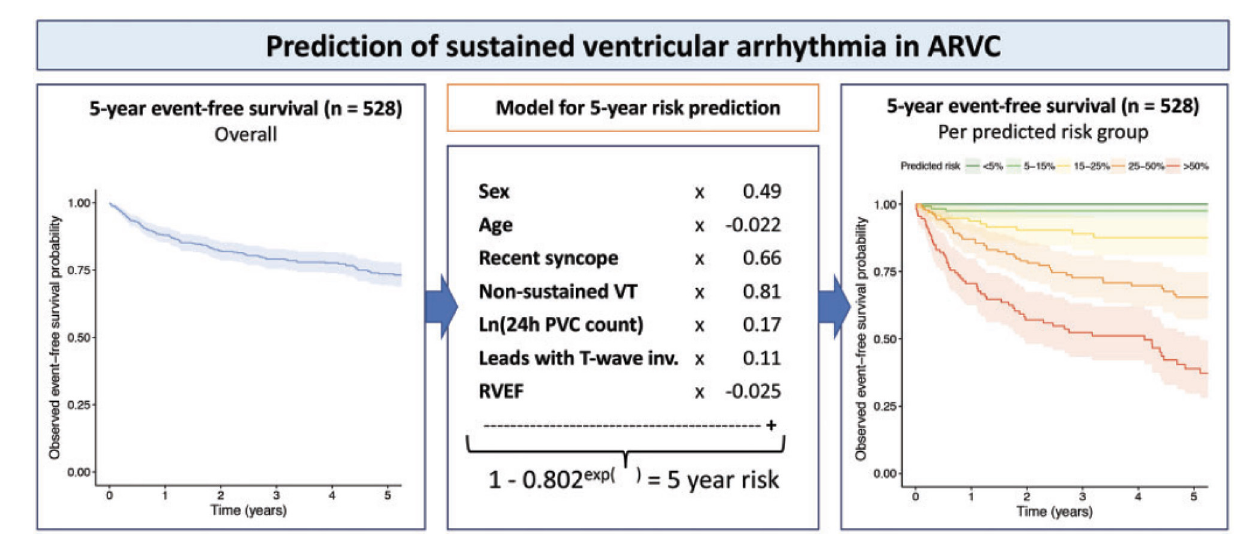
FIGURE 11 | Multivariable risk model to predict occurrence of first sustained ventricular arrhythmia in ARVC patients without prior arrhythmic events. Left panel denotes arrhythmia-free survival in 528 definite ARVC patients in North-America and Europe. Middle panel shows the derivation of a multivariable model for ventricular arrhythmia occurrence, using seven easily available clinical predictors. Right panel shows observed event-free survival stratified by predicted risk in the model. Source: (43), obtained with